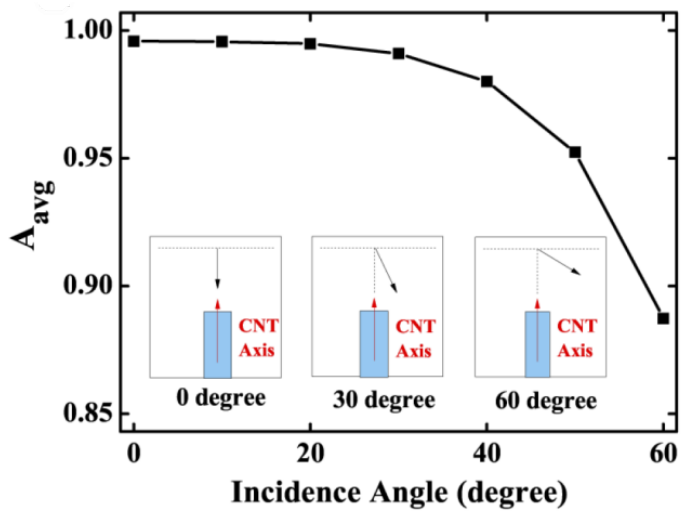
Figure 12. CNTs’ average light absorbance (A avg ) as a function of the light incidence angle. Repro- duced with permission from [132].